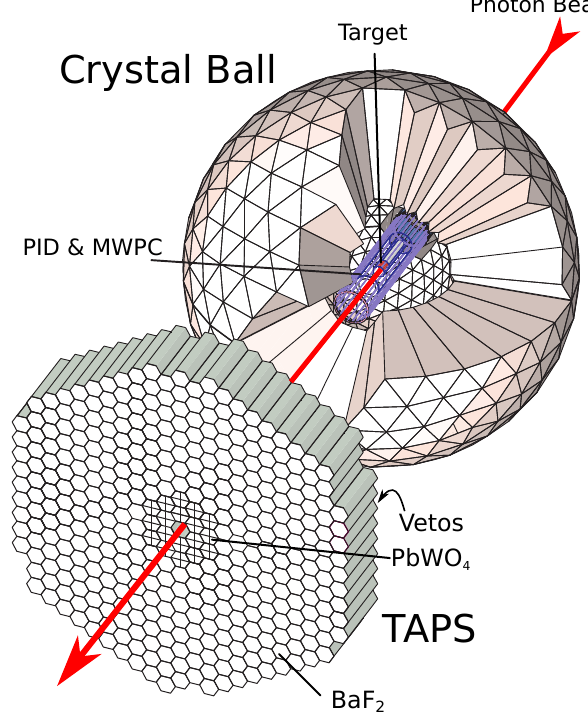
Figure 1. Schematic view of the Crystal Ball / TAPS detection system.